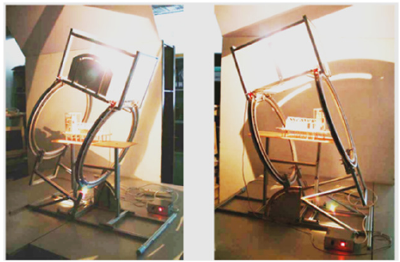
Figure 8. Novel heliodon with two-time rings designed by Cheung and Chung in 2002.